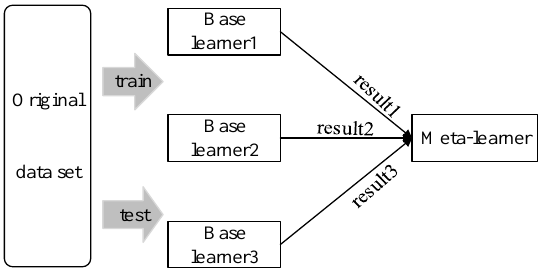
Figure 4. The Ba-stacking model architecture diagram. Figure 4. The Ba-Stacking model architecture